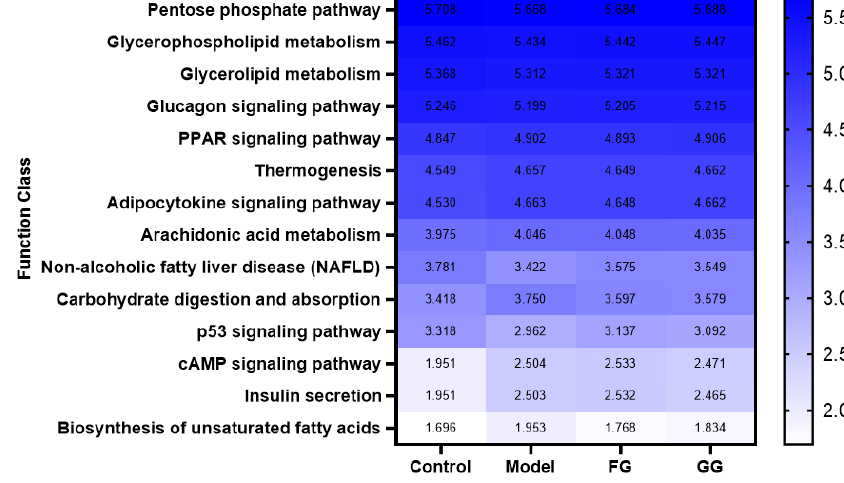
Figure 18. Heat map of KEGG pathway level 3 functional abundance ( n = 10).